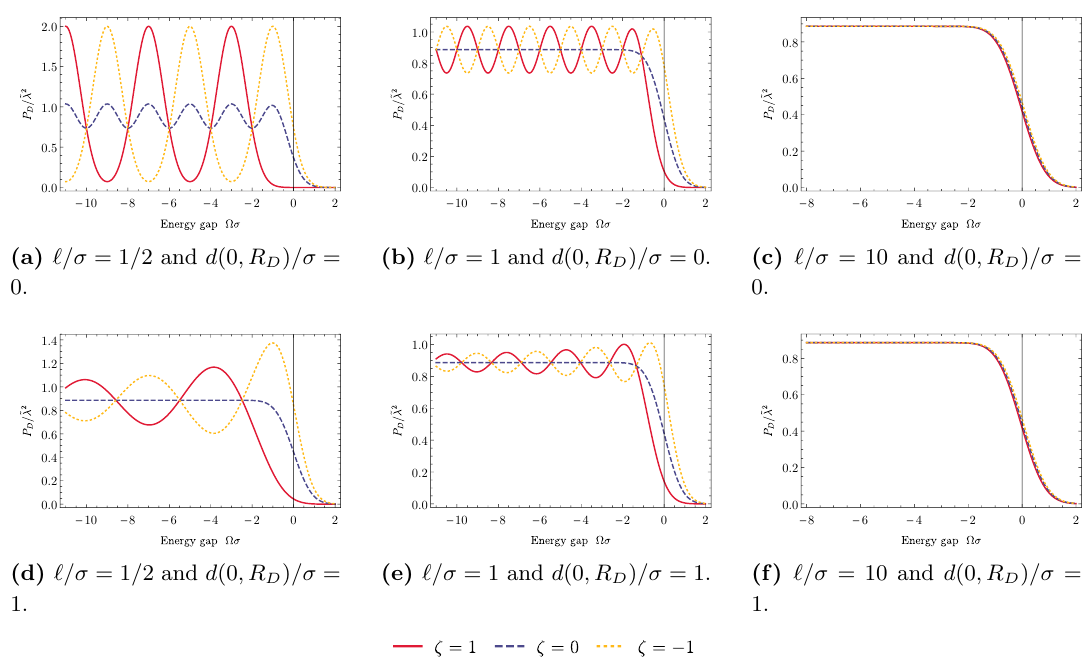
Figure 2 . The transition probability P D of a static detector is plotted as a function of its energy gap (cid:10) (cid:27) for all boundary conditions (cid:16) = f 1 ; 0 ; (cid:0) 1 g and various values of the AdS length ‘=(cid:27) . In plots (a), (b), and (c) the detector is located at the origin, while in plots (d), (e), and (f) the detector is located a proper distance d (0 ; R D ) =(cid:27) = 1 away from the origin. Negative energy gaps (cid:10) (cid:27) < 0 correspond to a detector that is prepared in its excited state j 1 i prior to interacting with the (cid:12)eld. D (Dirichlet) boundary conditions. If the (cid:12)eld satis(cid:12)es transparent boundary conditions then there is no correction to the (cid:13)at space result at order (cid:27)=‘